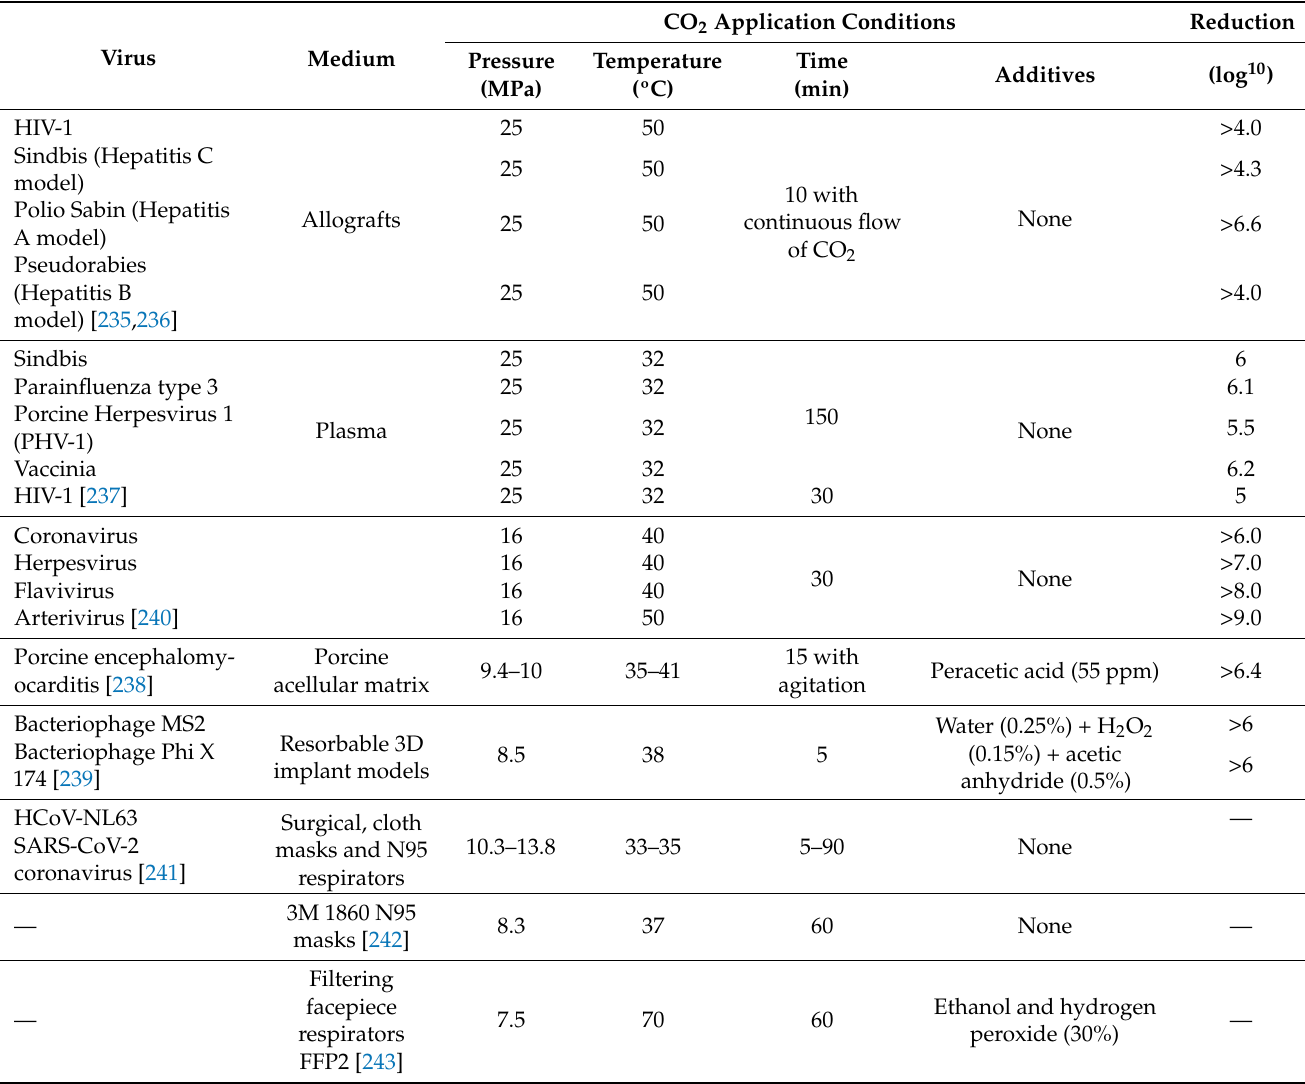
Table 5 lists the published work on the virucidal activity of supercritical CO 2 and that on materials involved in the COVID-19 crisis. Table 5. Virucidal activity of supercritical CO 2 and that on materials involved in the COVID-19